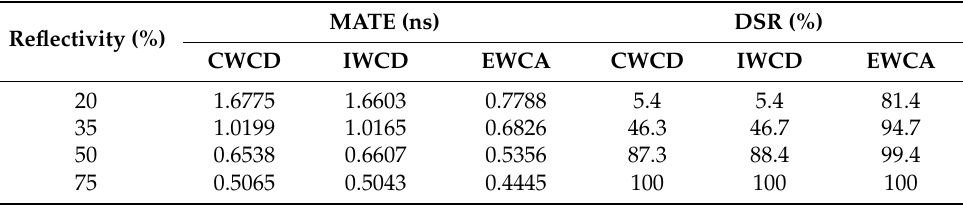
Table 4. The mean absolute time error and detection success rate under different reflectivity plates. MATE Reflectivity (%)